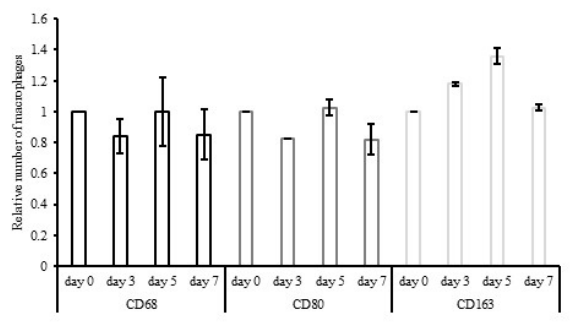
Biology 2021 , 10 , x FOR PEER REVIEW Figure A1. Viability of unburned tissue in vitro. Figure A1. Viability of unburned tissue in vitro.